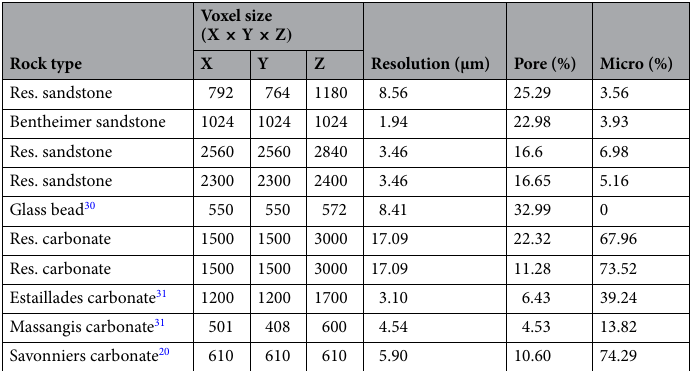
Table 1. Our training dataset consists of 10 high-resolution and low noise 3D Xray micro-CT images from different rock types. Pore and Micro are the volumetric fractions of resolved and unresolved porosity regions,